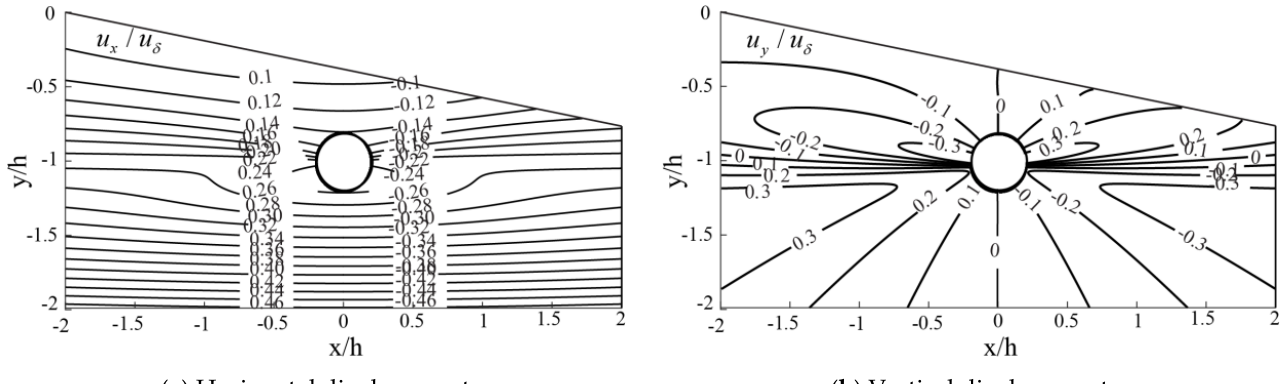
Figure 7. Displacement induced by uniform convergence.